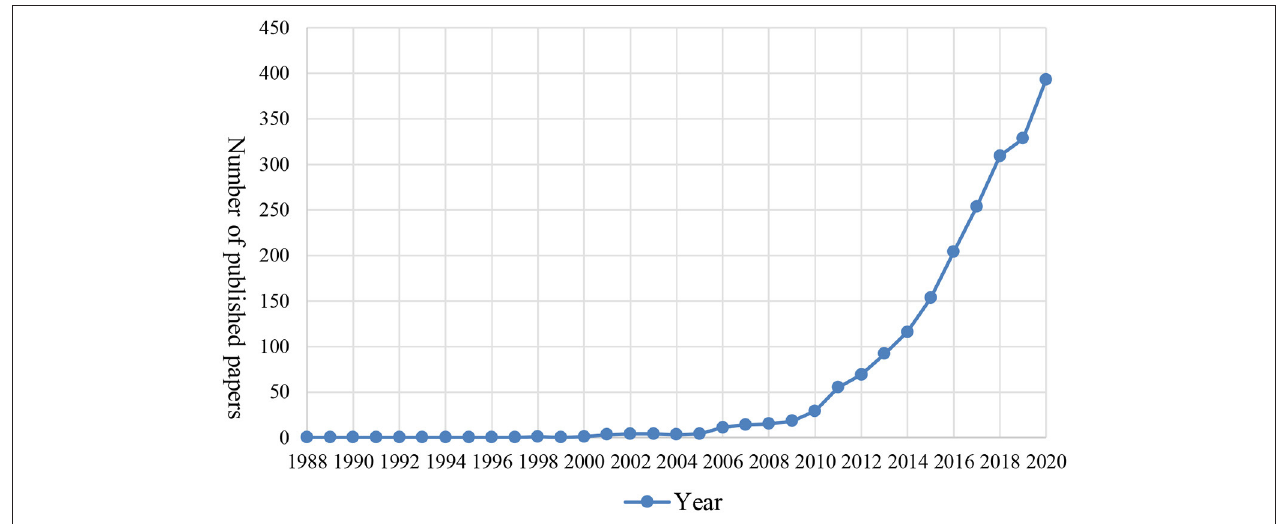
FIGURE 1 | Annual distribution of Chinese domestic publications on international student engagement indexed in